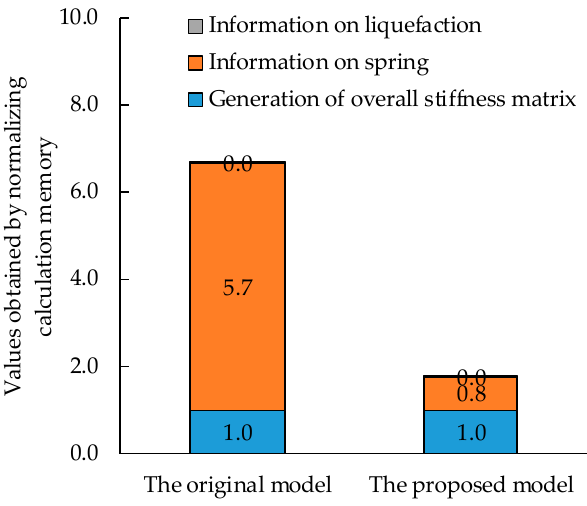
Figure 15. Required memory of finite element analysis in the high fidelity model using multiple shear mechanism model and excess water pore pressure model.